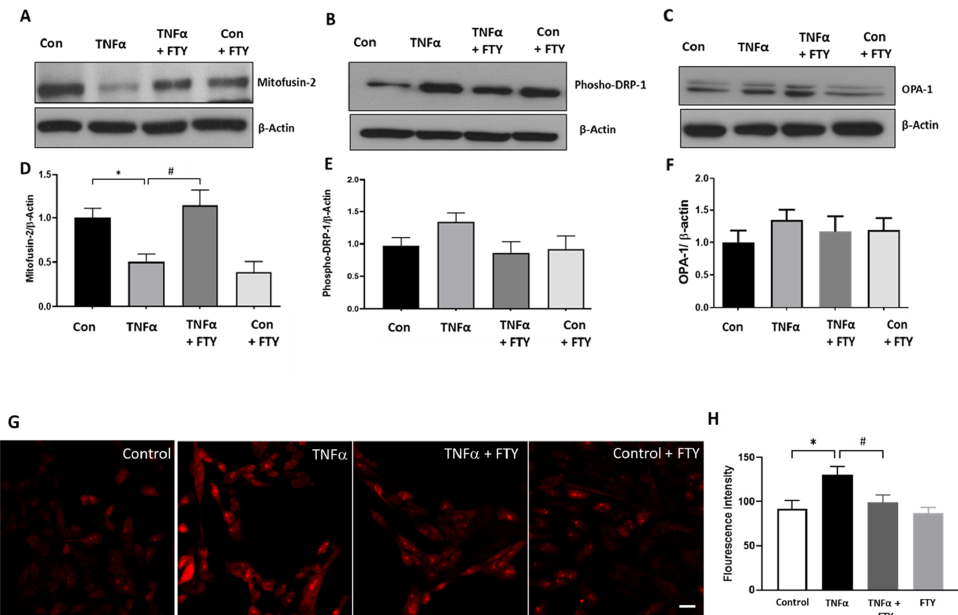
Figure 6. Changes in mitochondrial protein dynamics and ROS formation in response to Fingolimod treatment. ( A – C ) Representative Western blot data showing changes in expression of proteins associated with mitochondrial dynamics with TNF α treatment, and the effect of FTY cotreatment. ( D – F ) Respective bar graphs showing quantification of these proteins expression changes with TNF α treatment and any changes by co-treatment with FTY [* p < 0.05 vs. control; # p < 0.05 vs. TNF α ; N = 3]. ( G ) Representative images of Mitosox Red staining showing the impact of TNF α on mitochondrial reactive oxygen species (ROS) formation and the effect of FTY on the treatment. Scale bar 20 µm. ( H ) Quantification of fluorescence intensity showing of the increased mitochondrial ROS formation in response to TNF α treatment, which was reduced in the presence of FTY [* p < 0.01 vs. control; # p < 0.01 vs. TNF α , n = 3 per group].